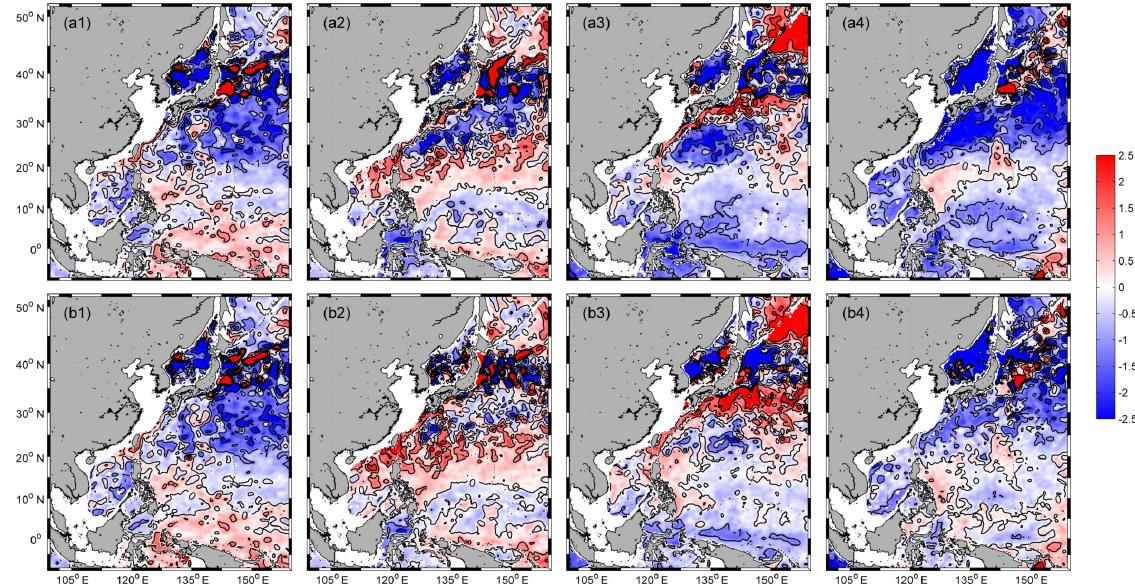
Figure 7. Monthly mean temperature bias at surface (in ◦ C) for (1) January, (2) April, (3) July and (4) October: (a) SST error calculated by SF and OISST; (b) SST error calculated by AF and OISST. Depths below 200m are masked